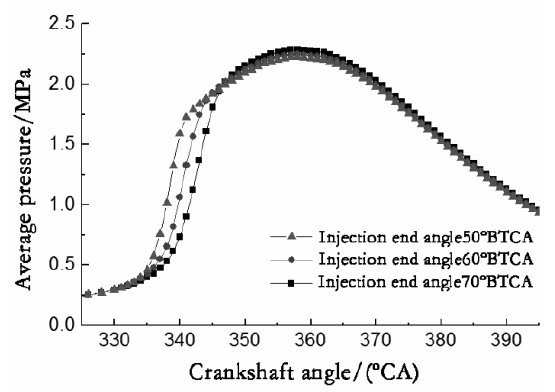
Figure 8. Average pressure in the cylinder at different injection end angles.